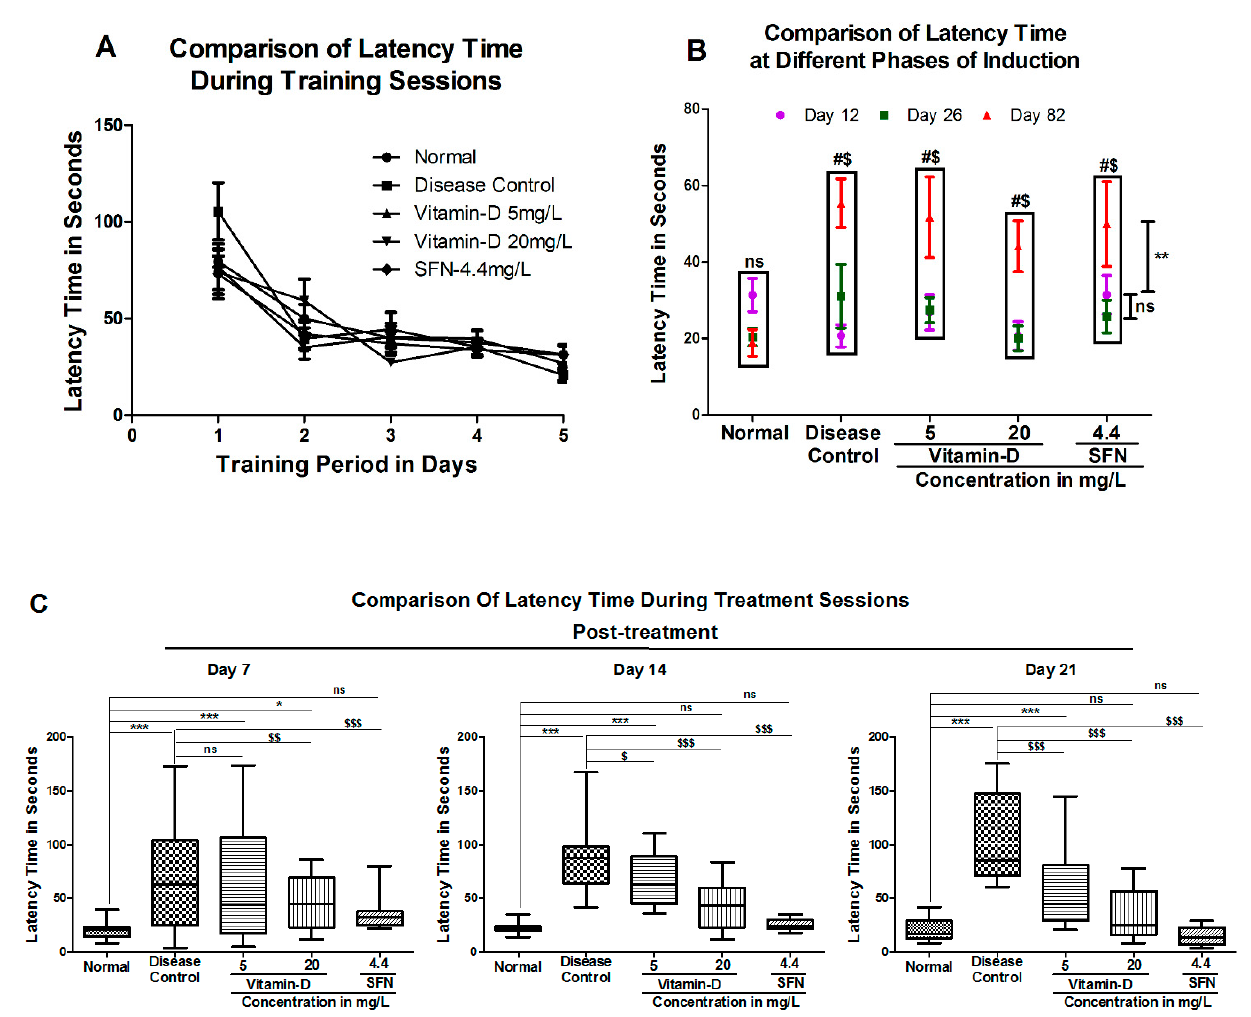
Figure 4. Vitamin D and SFN Could Reduce the Latency Time in Hyperglycemic Zebrafish. ( A ) A 5-days training reduced the latency period in zebrafish: Latency i.e., the time taken to reach the deep square chamber of T-maze, was assessed during the training session in all the groups ( n = 15) for 5 days. A time dependent decrease was observed with the increase in training time. ( B ) Hyperglycemic environment increased the latency time in zebrafish. Zebrafish growing in 111 mM glucose containing water exhibited ~3 fold higher latency time (at day 82) to reach the deeper square chamber compared with the latency time required at day 12. “**” represents significance between day 12 and day 82 with p < 0.001; “#” represents significance in latency time between day 26 and day 82 at p -value < 0.05; “$” represents significance in latency time compared with the normal control group at day 82 with p -value < 0.05. ( C ) Treatment of hyperglycemic zebrafish with vitamin D and SFN reduced the latency time: Treatment of hyperglycemic zebrafish with 5.0 mg/L and 20 mg/L vitamin D reduced the latency time by 1.5 to 2.0 fold. The data shown represents mean ± SEM with ONE-way ANOVA, followed by Tukey’s post-hoc test using multiple comparisons option. The “***” & “*” represents a significant difference compared with normal control with p < 0.0001 & p < 0.05 respectively and “$$$”, “$$” & “$” represents significant difference compared with disease control with p < 0.0001, p < 0.001 and p < 0.05 respectively. “ns” represents